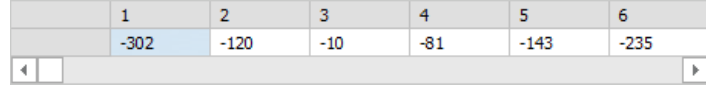
The following additional abbreviations are used in Table 3: F—frame, P—point, X—X coordinate, Y—Y coordinate. Each stimulus file is 20,100 bytes in size. The last 100 bytes